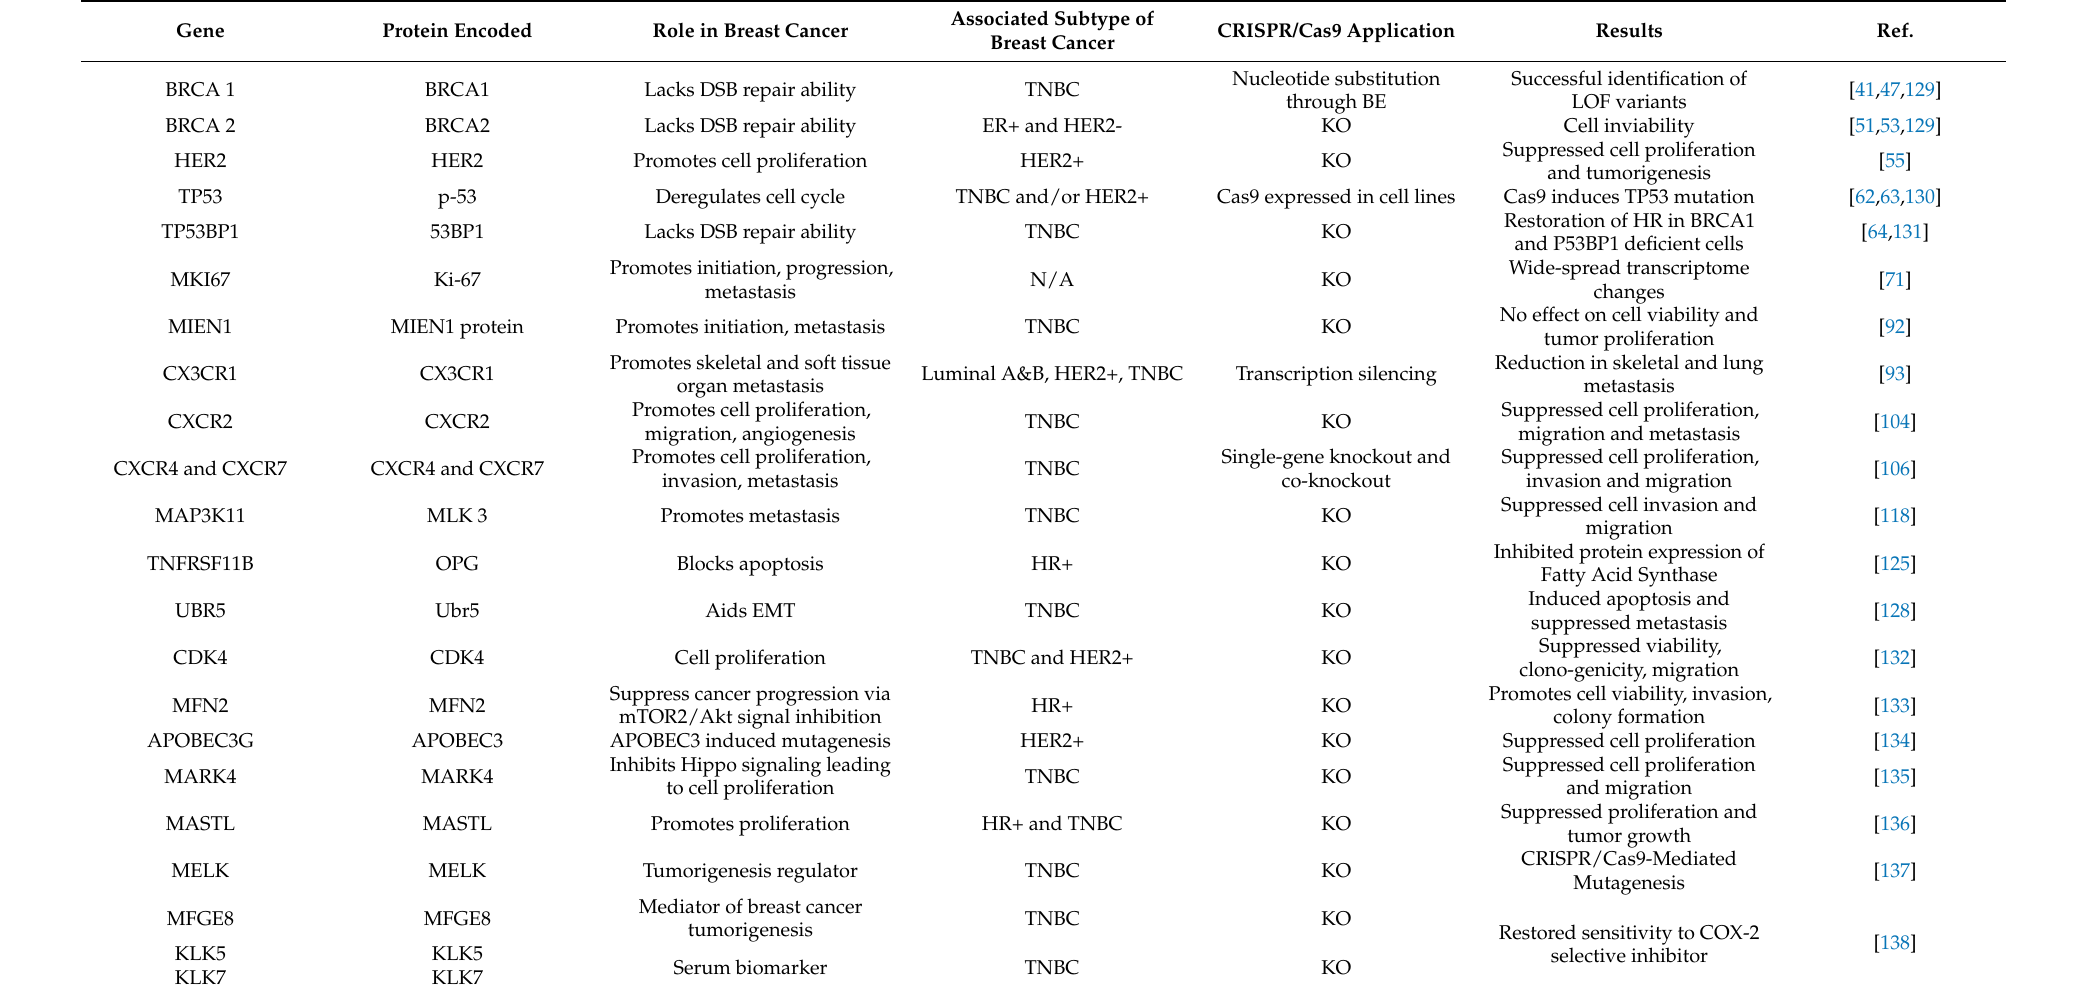
Table 2. An overview of the potential therapeutic targets for breast cancer studied in literature employing the CRISPR/Cas9